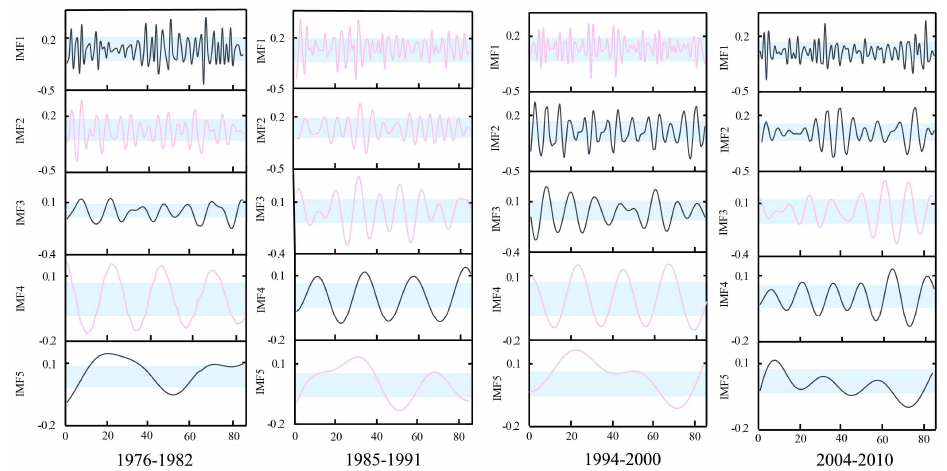
Figure 12. Similarity of segmented IMFs at Gaojiabao gauge. The pink lines in segments